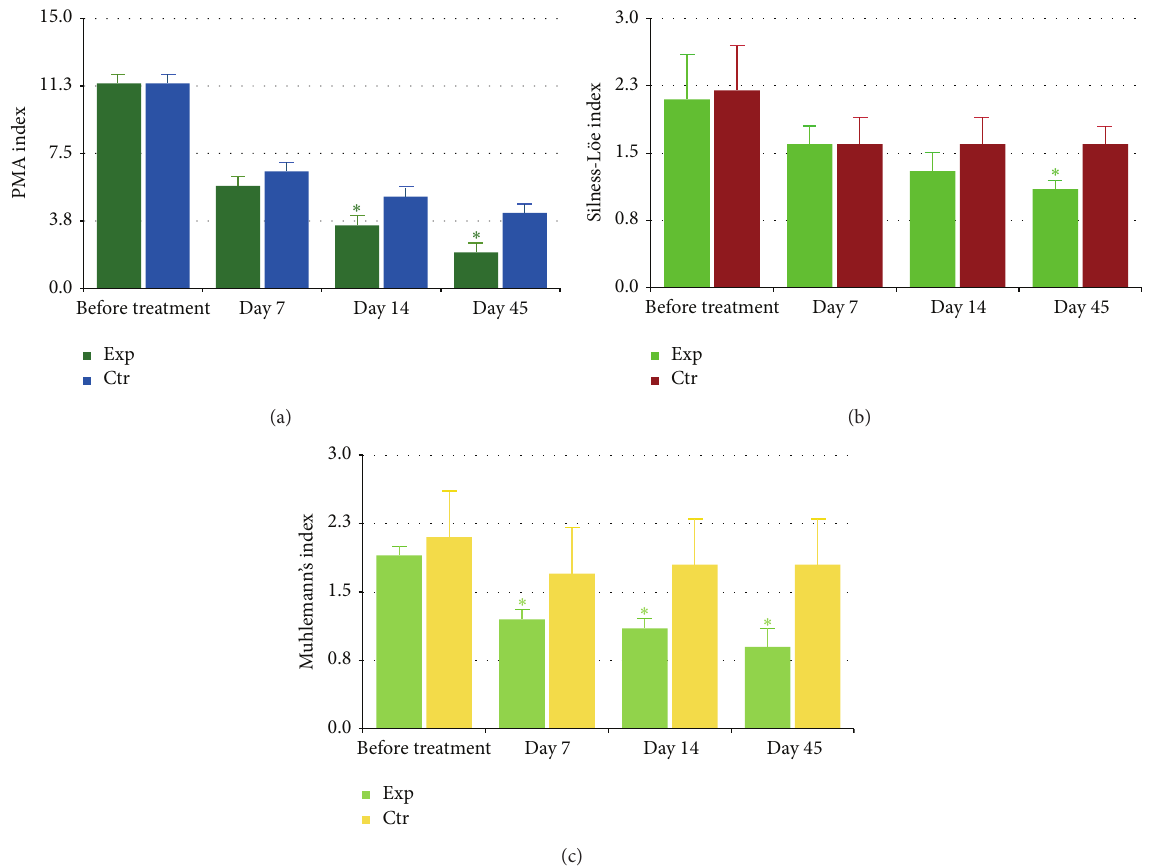
Figure 1: Dynamics of the clinical indexes of periodontitis severity: PMA (clinical attachment and pocket depth index) index (a); Silness- L¨oe (gingival and plaque) index (b); Muhlemann’s (bleeding on probing) index (c). The experimental group (Exp, 𝑛 = 39 ) was treated with conventionalperiodontaltreatmentplustopicaldailyapplicationoffermentedpapayagelintogingivalpockets;thecontrolgroup(Ctr, 𝑛 = 45 ) received conventional periodontal treatment for the same period of time. Values are represented as mean and standard deviation of the mean (SD). ∗ 𝑃 < 0.05 versus